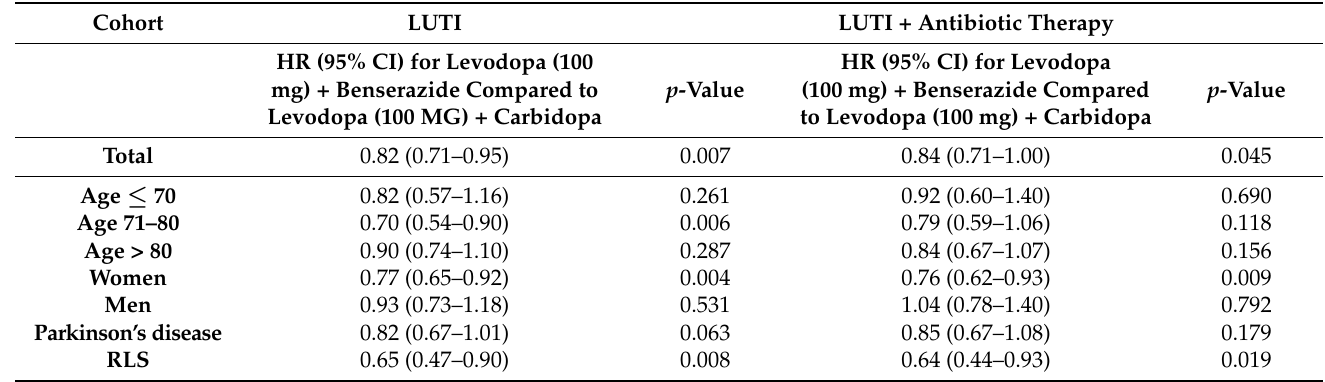
Table 2. Association between levodopa combination therapy and LUTI diagnosis as well as antibiotic prescriptions in patients followed in general practices in Germany (Cox regression